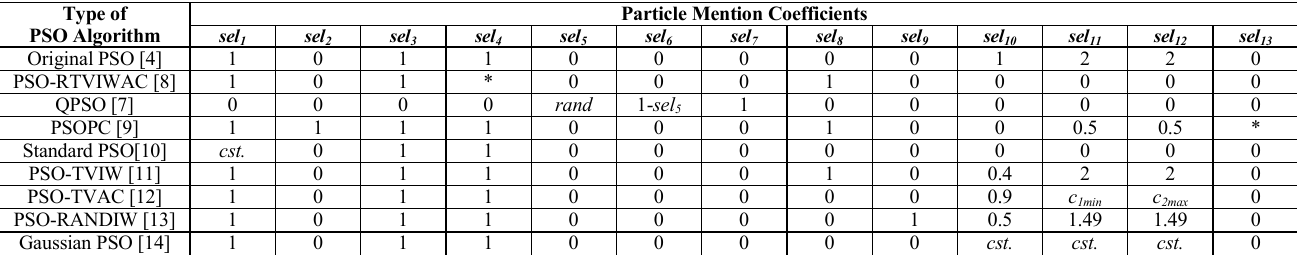
TABLE I. T HE EXAMPLES OF PARTICLE MOTION COEFFICIENT FOR CHANGING TYPE OF PSO